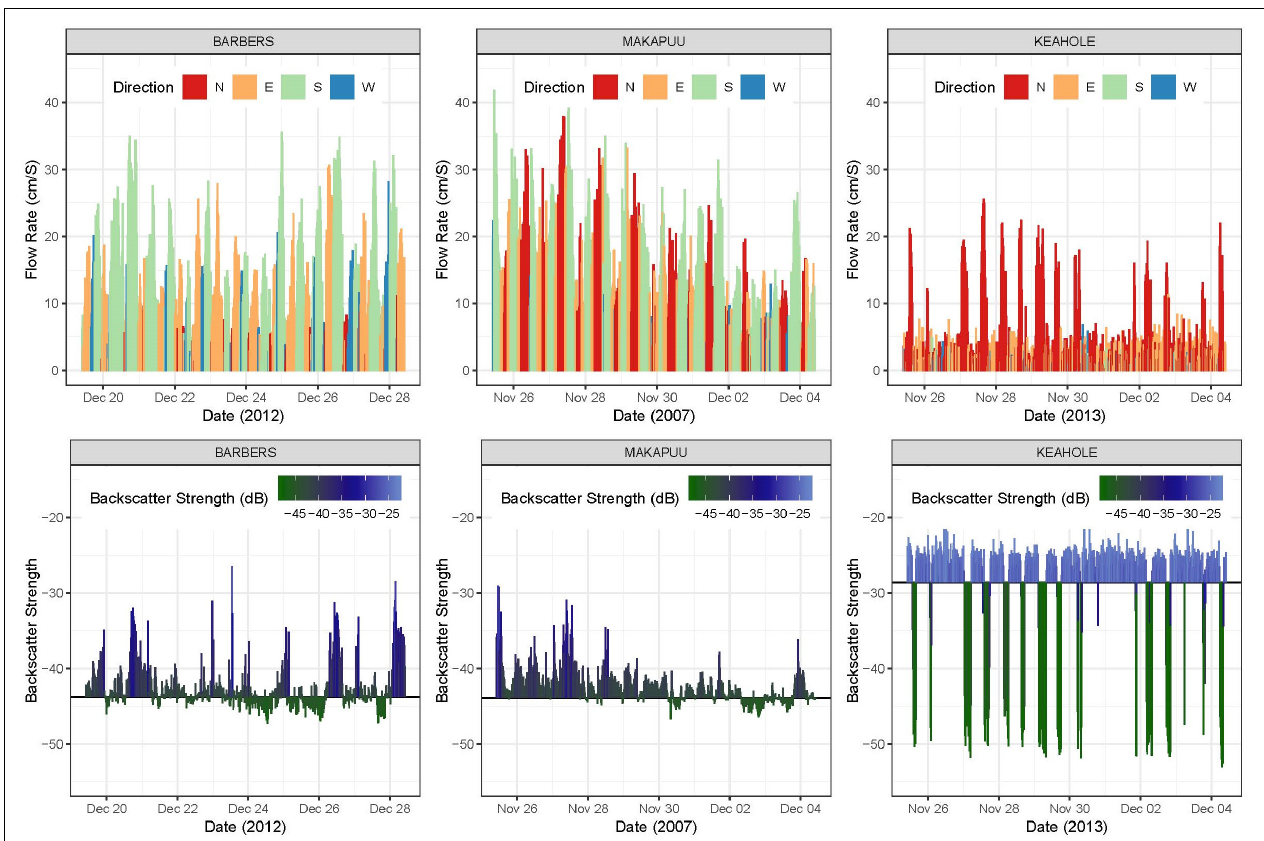
FIGURE 4 | Representative current flow (top row) and backscatter data (bottom row) for a 10-day period showing the Keahole Pt. patch having a stronger average scattering signal than the other two coral patches. Also evident at Keahole Pt. is a drop in the scattering strength correlated to pulses of northern